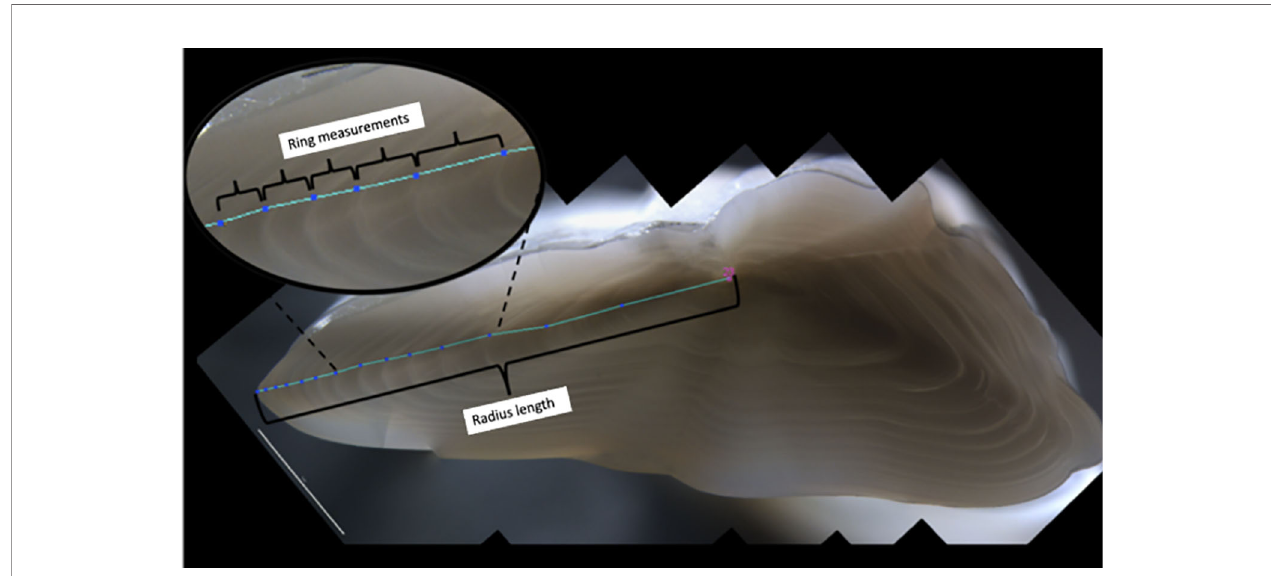
FIGURE 2 | Transversal section of an Atlantic cod otolith. Radius length indicates measurement from nucleus (pink number) and otolith edge. Annual ring measurements were zoom in the upper left panel. Measurements were taken from nucleus to the border. Growth rings were identi fi ed and marked (blue dots) and distance between them (cyan line) were automatically measured by the Image J